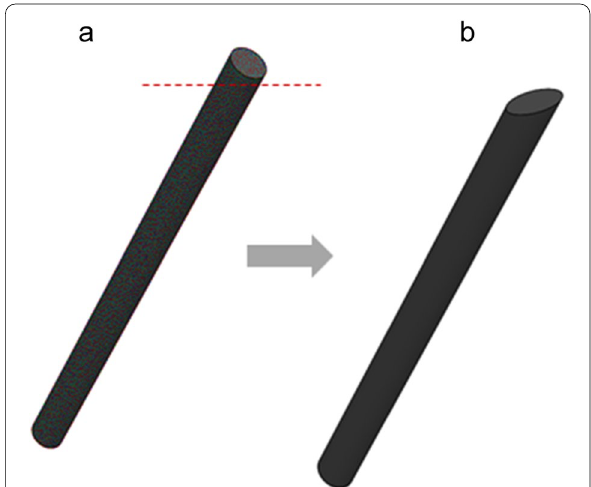
Fig. 4 Cross-sectional area ( a ) of yarn converted to the effective cross-sectional area( b